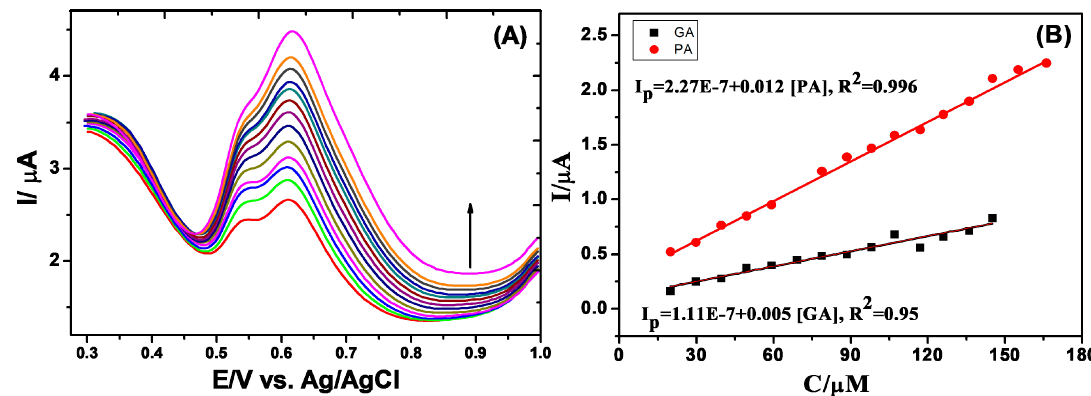
Figure 5. (A ) SWV profiles at the rGO/GCE in 0.04 M B–R buffer (pH 2.10) for different concentrations of GA and PA, and the ( B ) calibration plots.